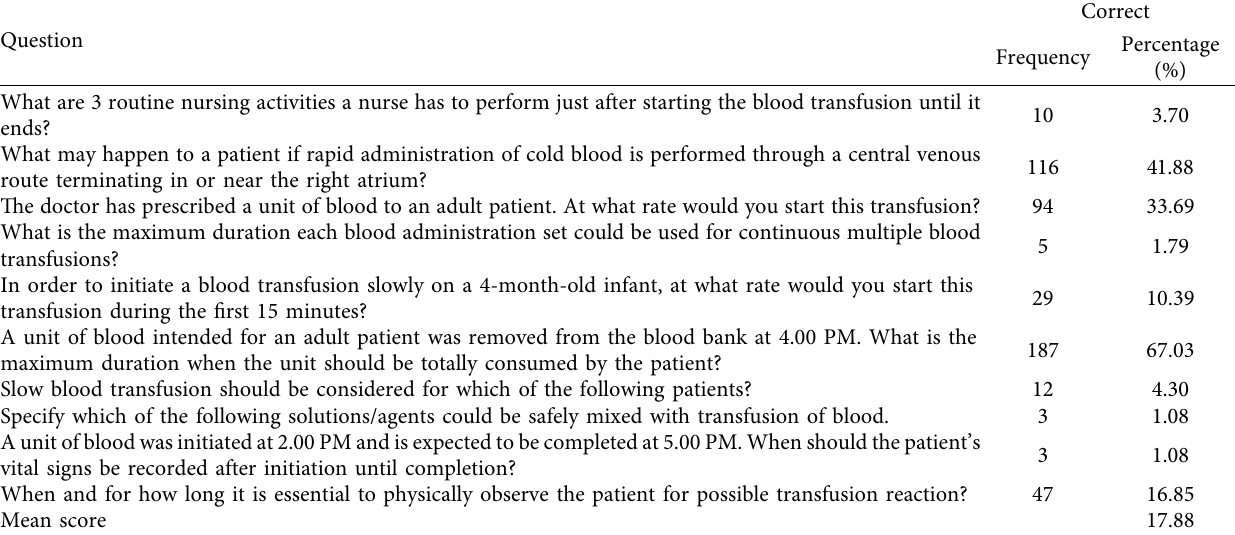
Table 7: Nurses’ knowledge of posttransfusion nursing activities.